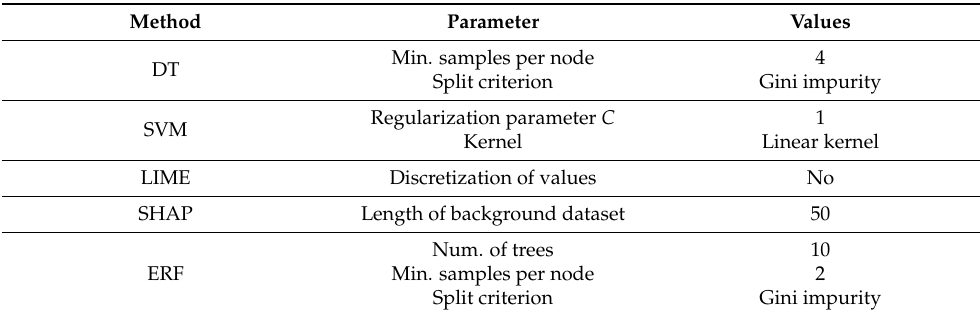
Table 5. Configuration setting per feature selection